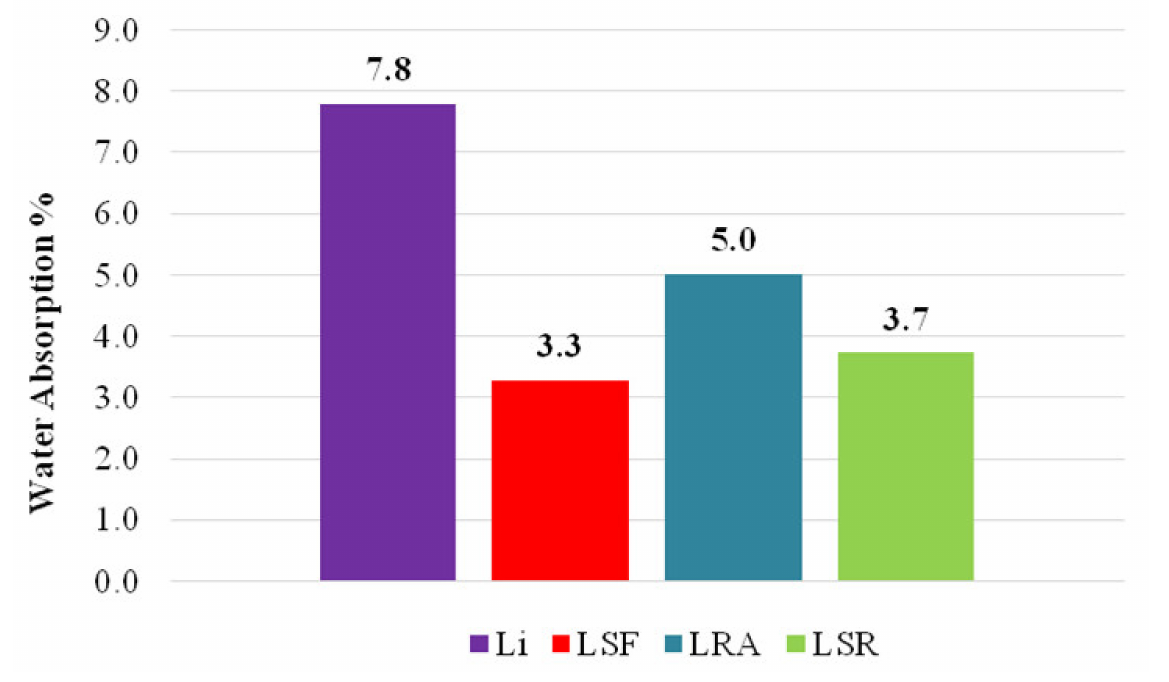
Figure 11. Water absorption of lime and lime composite